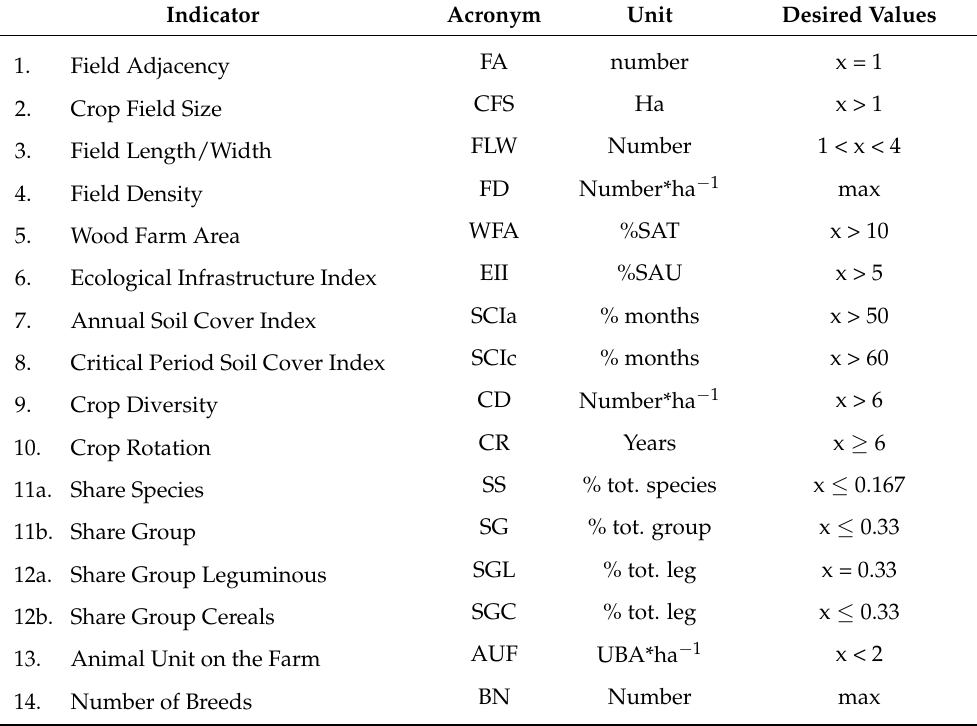
Table 2. List of the selected Indicators and their desired